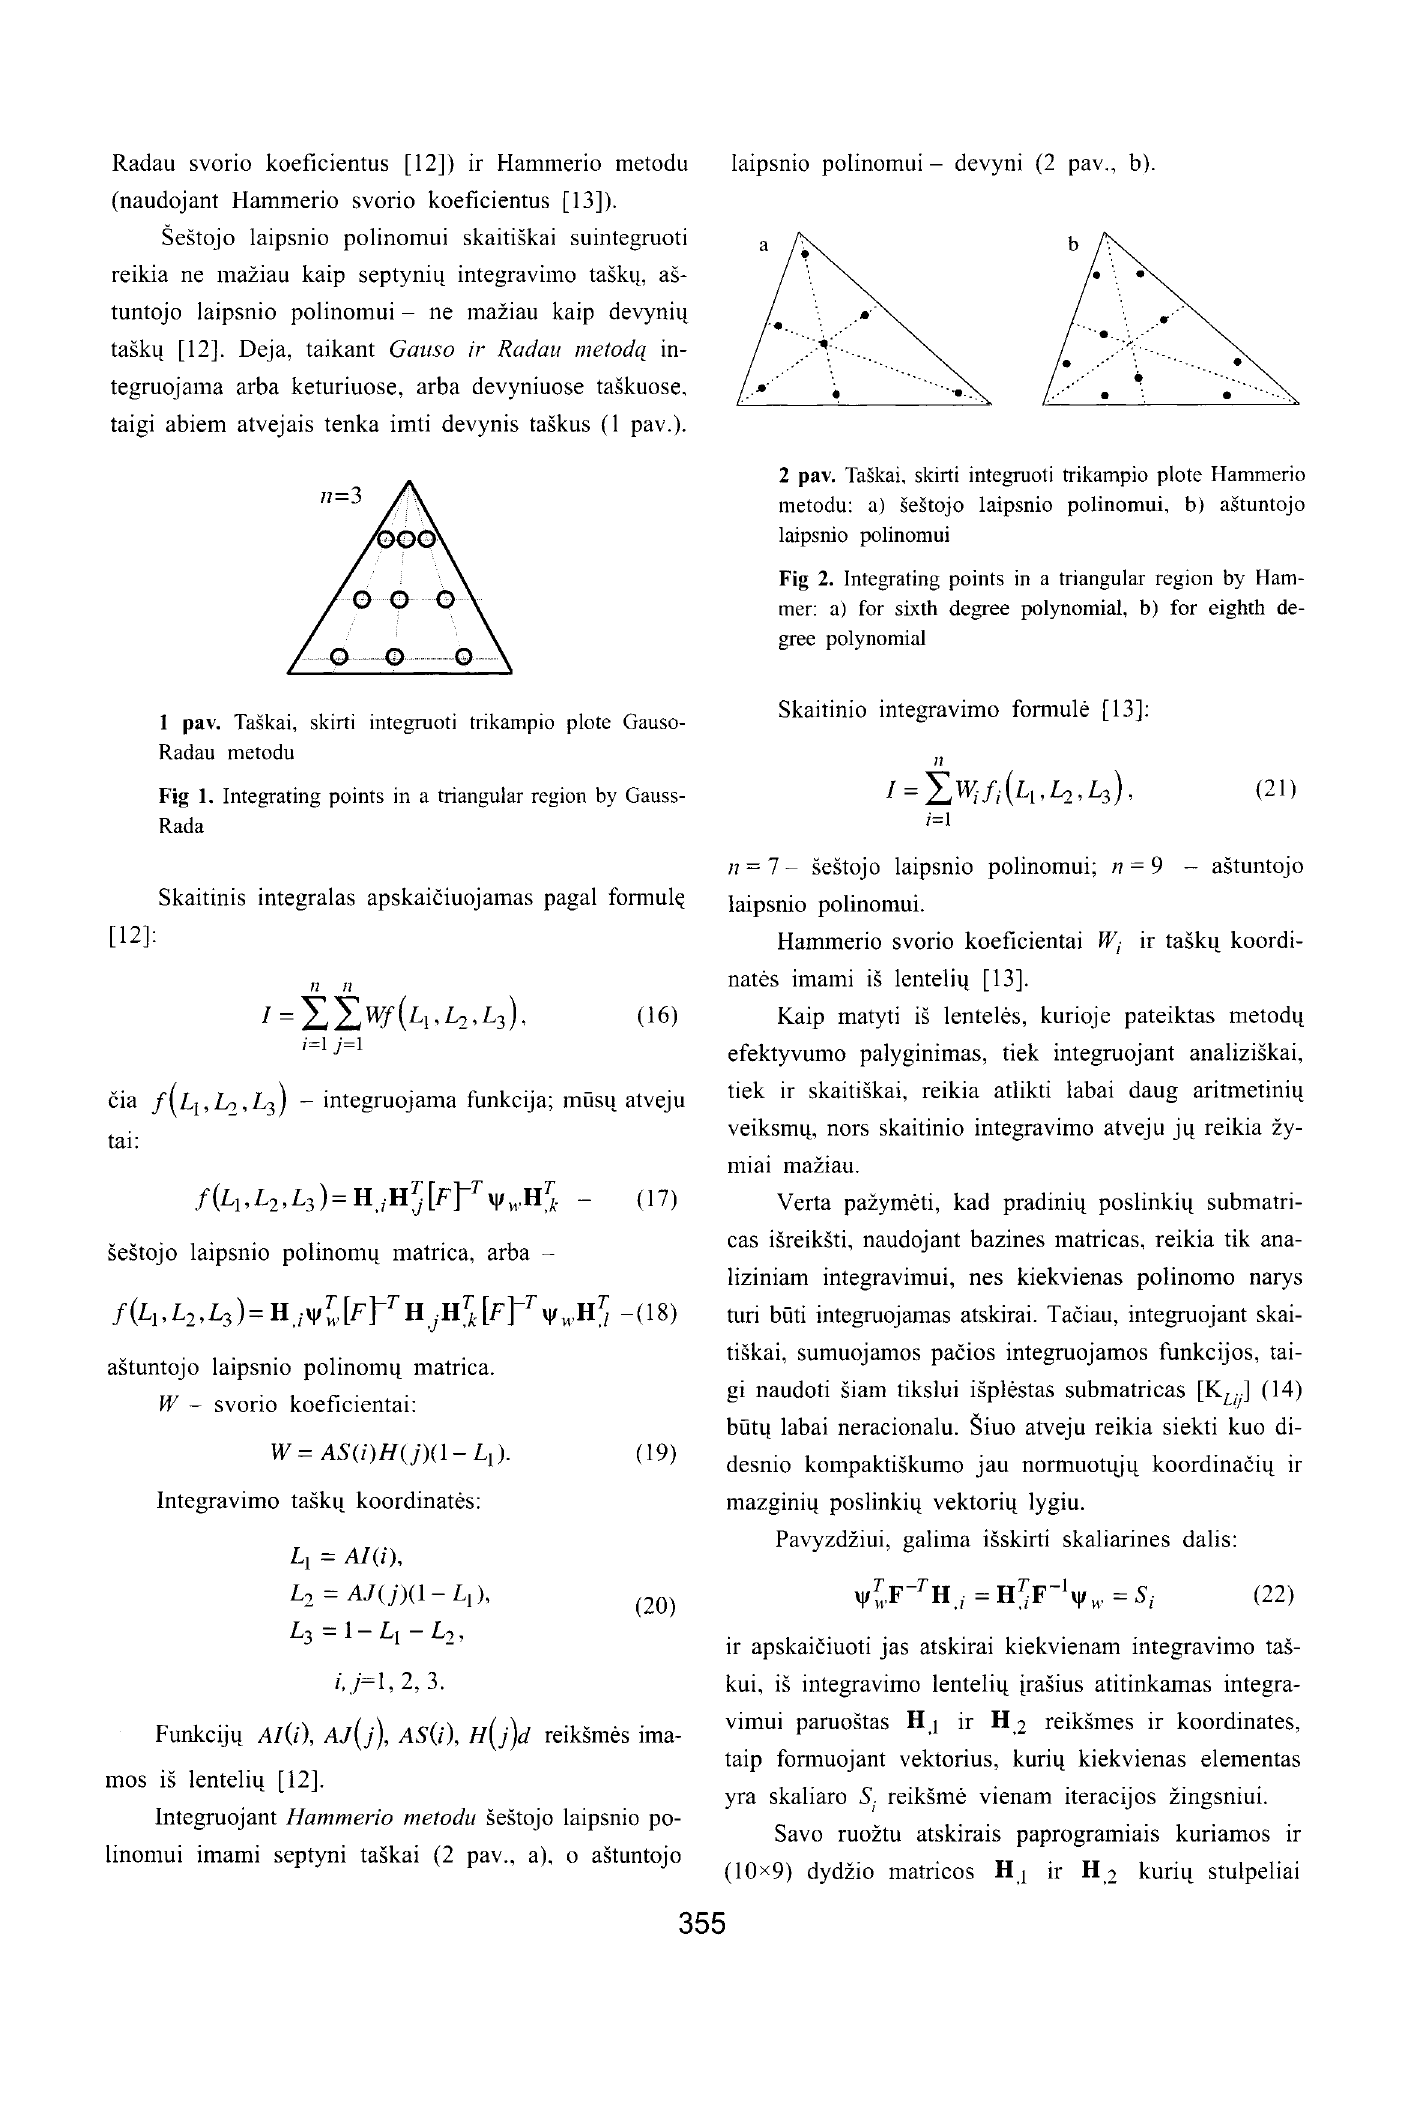
Radau metodu Fig I. Integrating points in a triangular region by Gauss Rada Skaitinis integralas apskaiciuojamas pagal fommh~